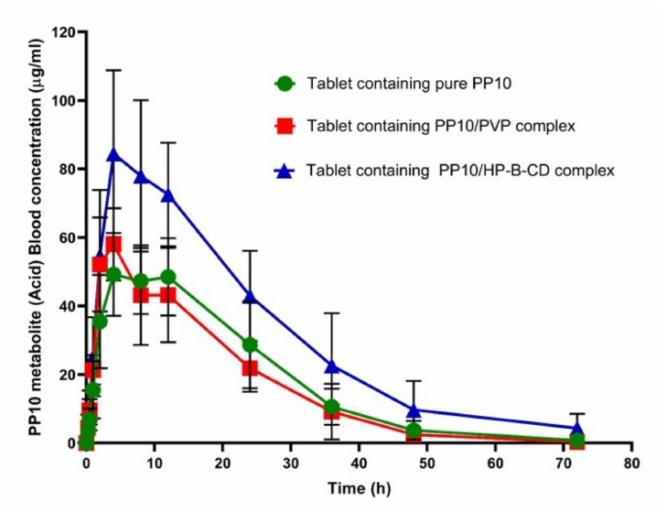
Figure 4. Plasma concentration–time curves for PP10-acid metabolite after oral administration of the